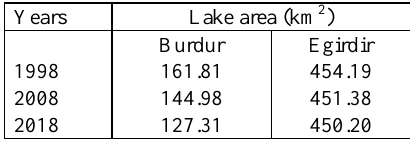
Table 2 . The lake areas for the years 1998, 2008 and 2018. The obtained LSWT maps for the Burdur and Egirdir Lakes are given in Figure 5 and 6, respectively.